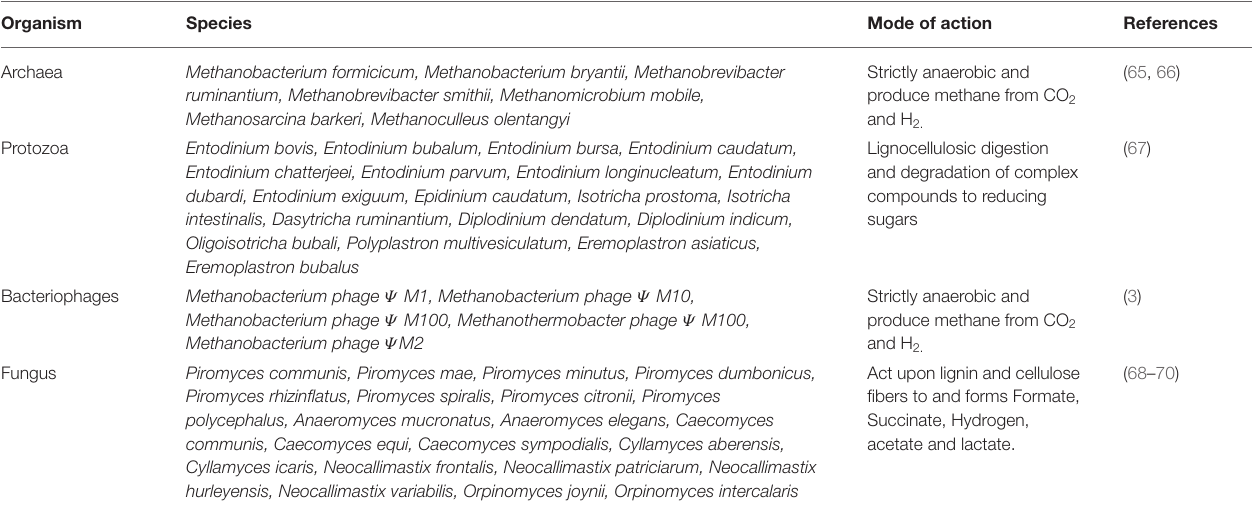
TABLE 3 | Various microflora in